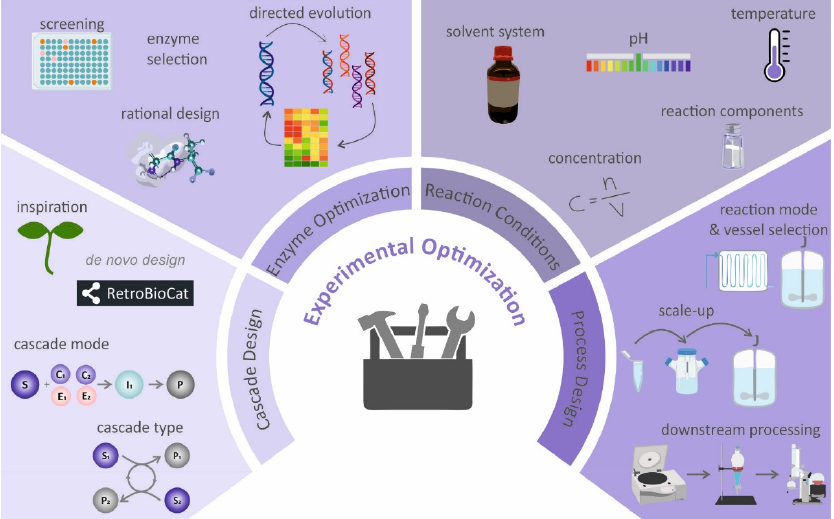
Figure 3. Experimental optimizations can be divided into cascade design, enzyme optimization, optimization of reaction conditions and process design. Each of these approaches have their own toolbox for the alteration of the cascade’s performance. Cascade design can be inspired by natural pathways or designed de novo while several cascade modes and cascade types are available. Enzymes properties can be adjusted by rational design or directed evolution if screening does not result in the identification of a suitable catalyst. Optimization of the reaction conditions include the adjustment of the solvent system, the concentrations of reaction components as well as reaction parameters (such as pH, temperature amongst others). Finally, the scale-up, reaction mode and downstream processing of the system can be addressed to provide cascade products in larger quantities and purified